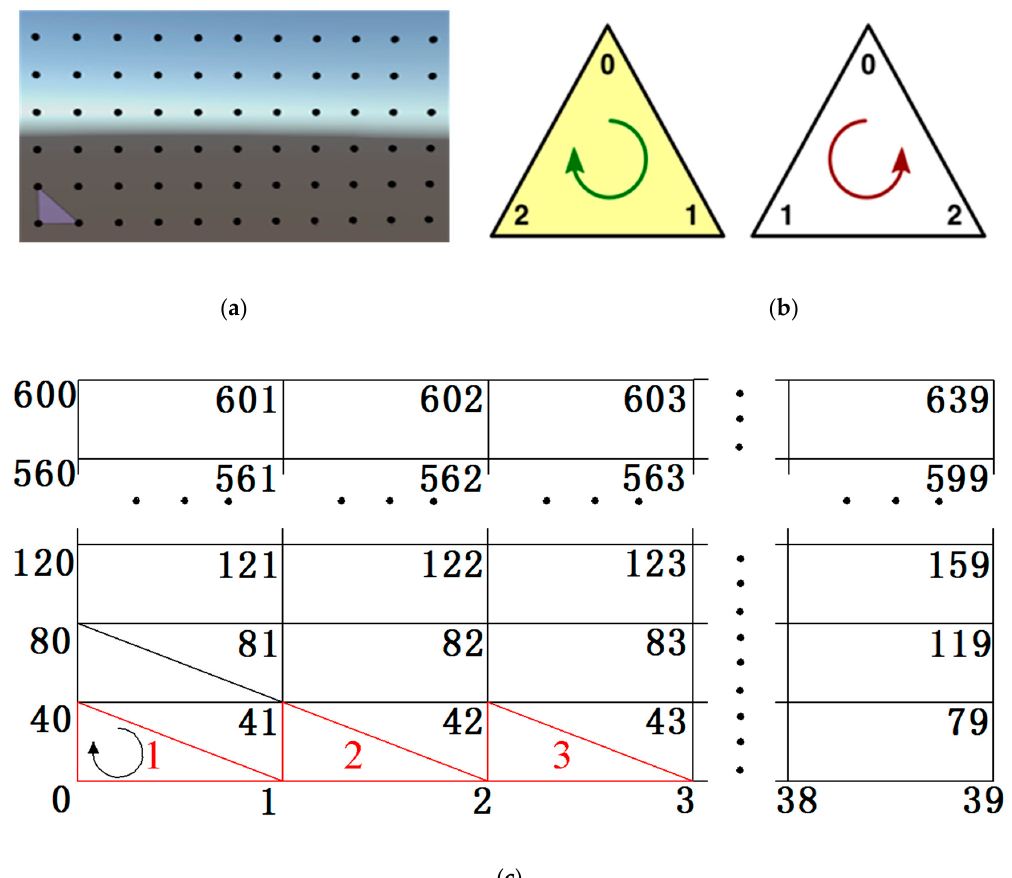
Figure 6. Rules for sorting triangular vertices in roof and floor mesh: ( a , c ) connection order of triangle vertices; ( b ) clockwise and counterclockwise connections.